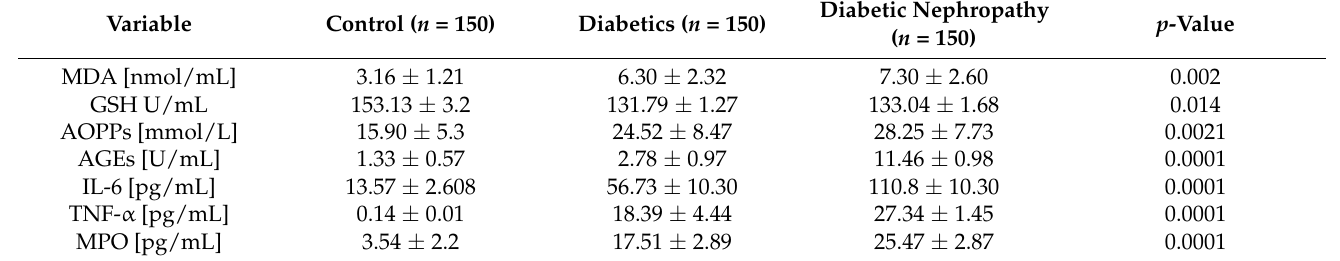
Table 3. Levels of circulating stress markers, inflammatory cytokines in controls, diabetics, and di- abetic nephropathy patients.